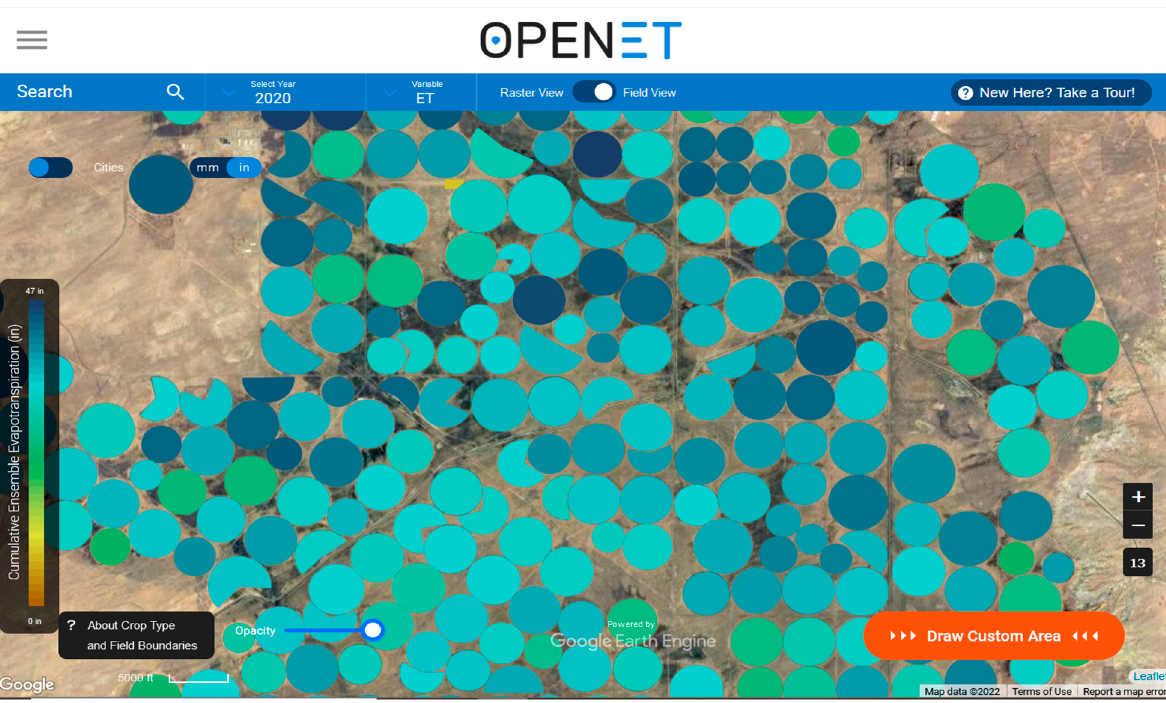
Figure 2. The OpenET Data Explorer showing the fields across Region 2 of the Navajo Agricultural Products Industry